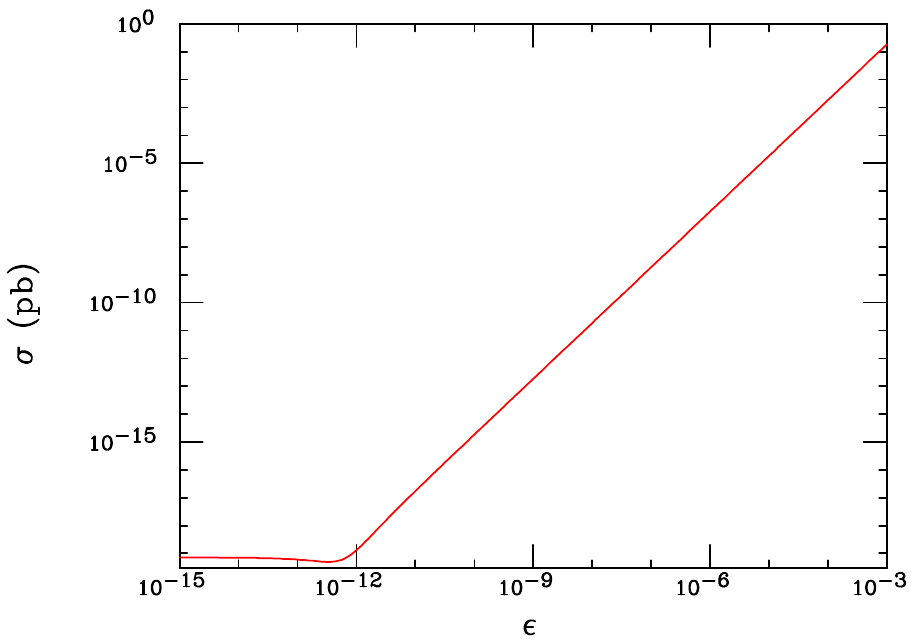
Figure 5 . DM-electon scattering cross section as a function of (cid:15) assuming that m V = 100 MeV, β φ = 10 − 3 , Λ e /α D = 25 TeV and α D = 0 . 5 for purposes of demonstration, as discussed in the text; G = 1 has been assumed